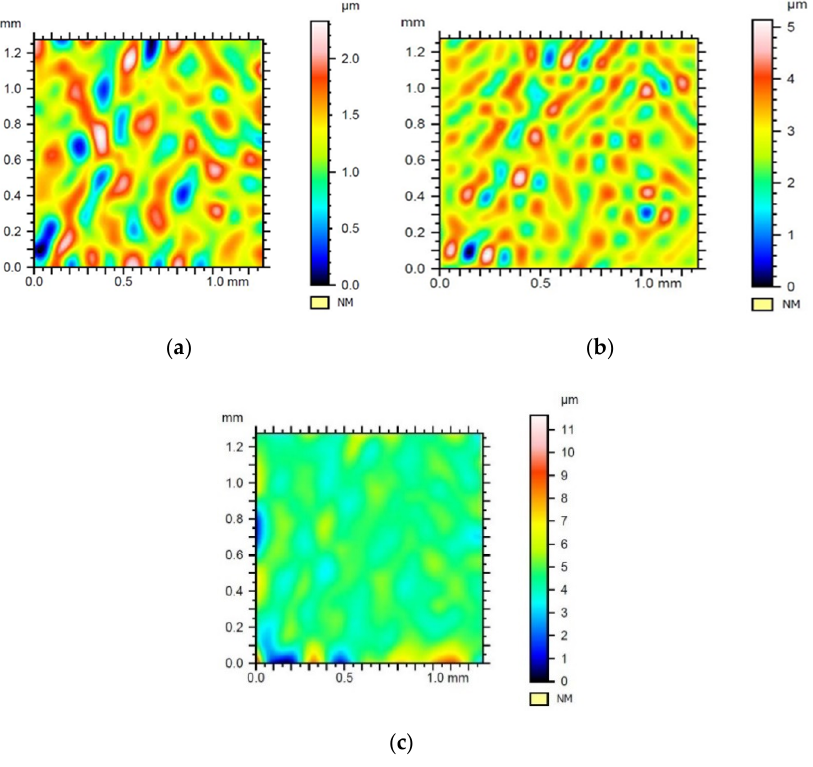
Figure 17. Surfaces created as a result of subtracting structure obtained with a wavelet from the structure after applying Gauss filtering: ( a ) Daubechies wavelet, ( b ) Morlet wavelet, ( c ) Mexican hat wavelet. The root mean square error: ( a ) 0.36 μm, ( b ) 0.62 μm, ( c ) 0.68 μm.